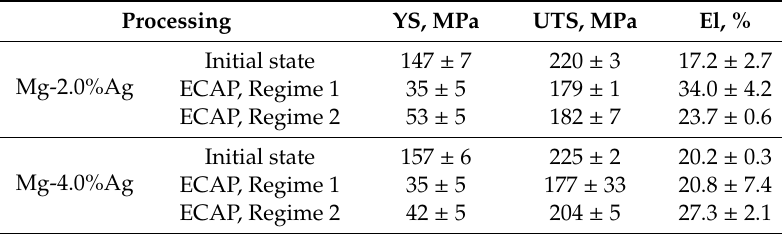
Table 1. Mechanical properties of Mg-2.0% Ag and Mg-4.0% Ag alloys in various stat es.